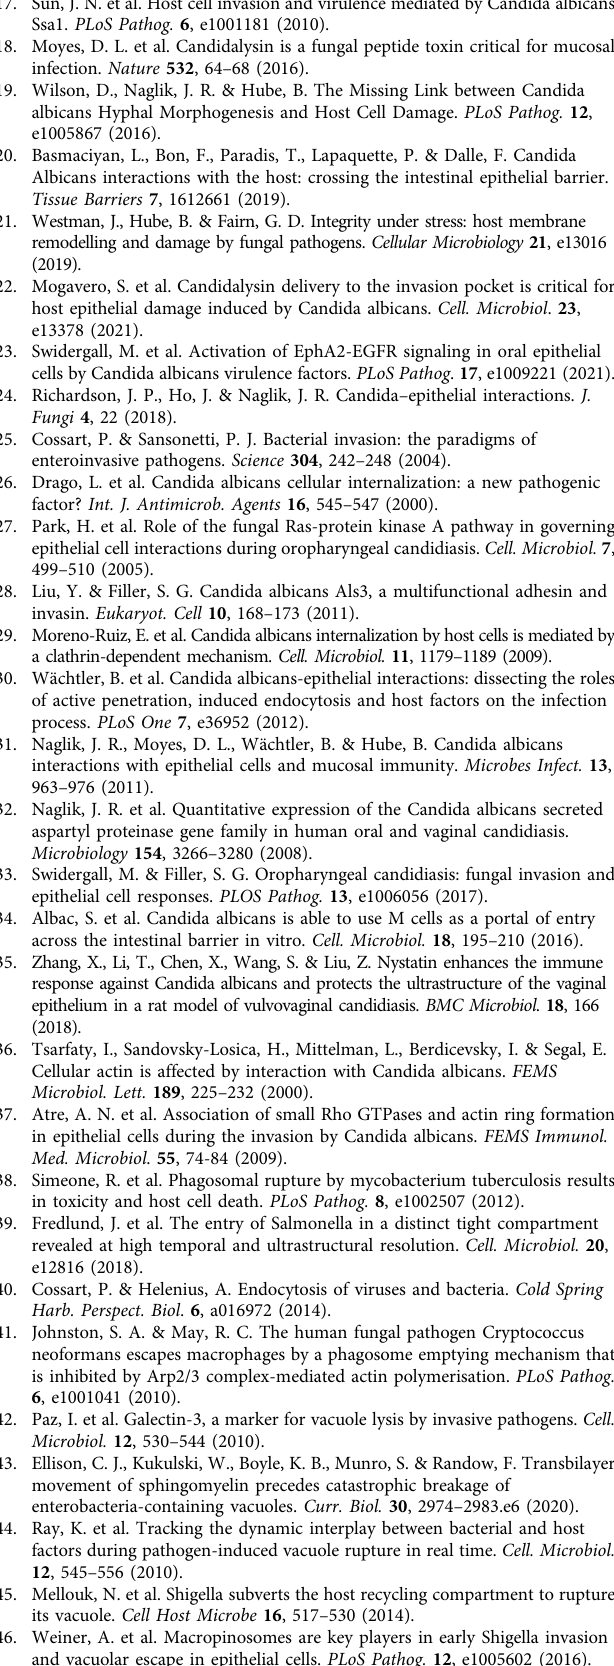
Supplementary Fig. 7: representative image of observations made in the datasets used in Fig. 1. Supplementary Fig. 8: 2. Supplementary Tables 1: 3, and 2: quan- ti fi cation of data presented in Figs. 4 and